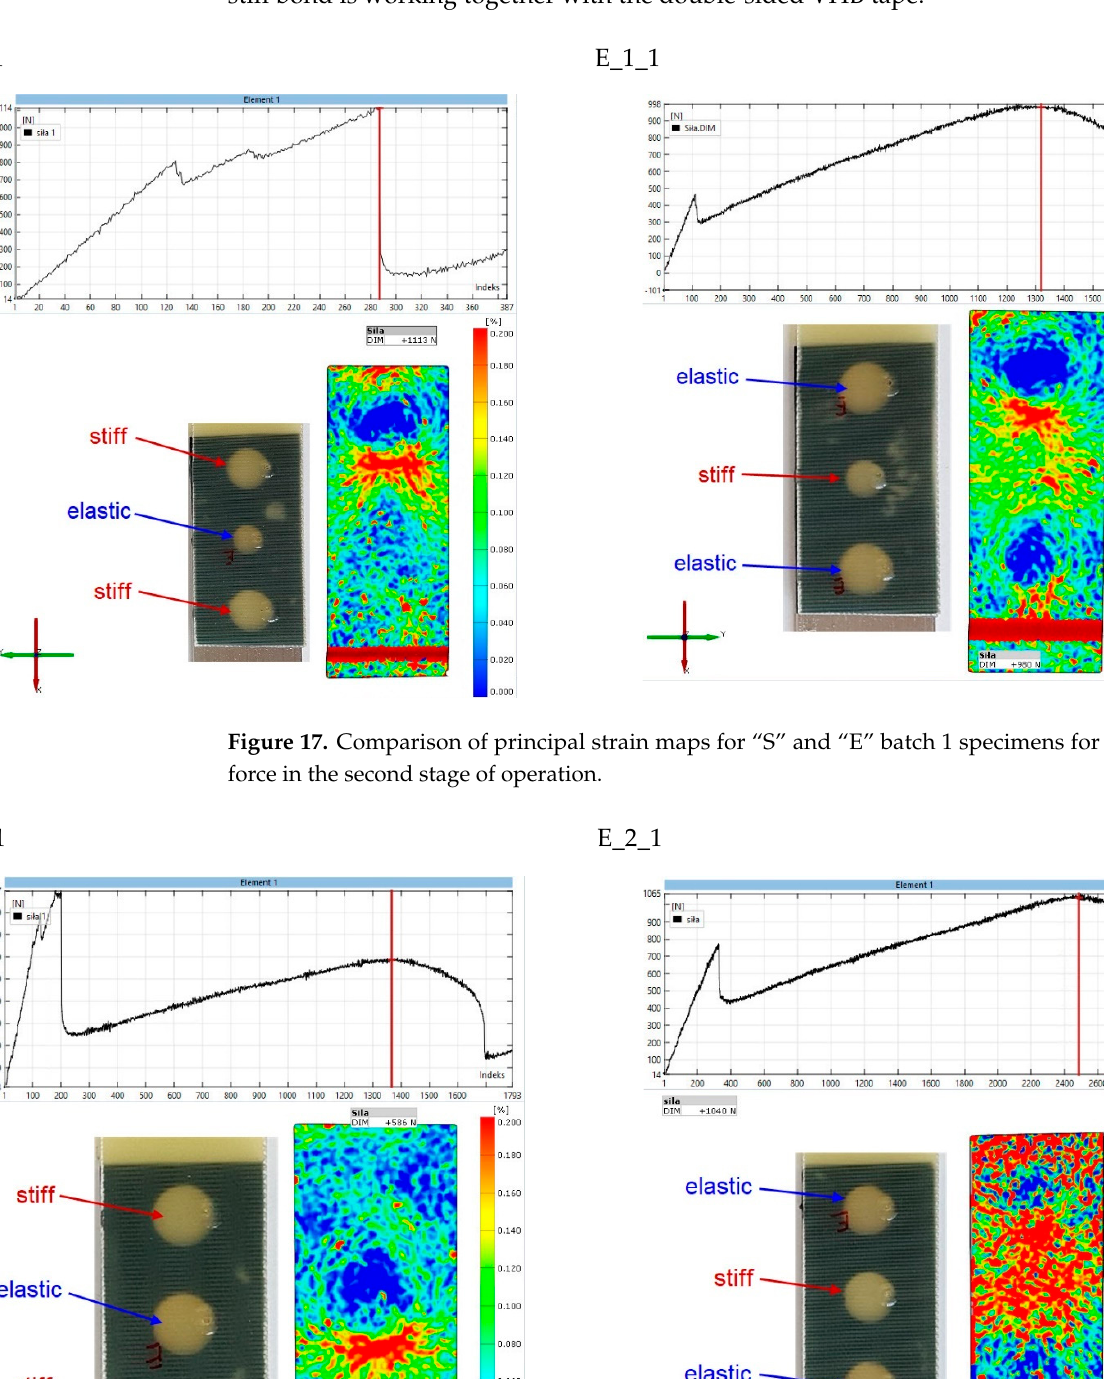
Figure 19. Comparison of principal strain maps for “S” and “E” batch 3 specimens for maximum force in the second stage of operation.